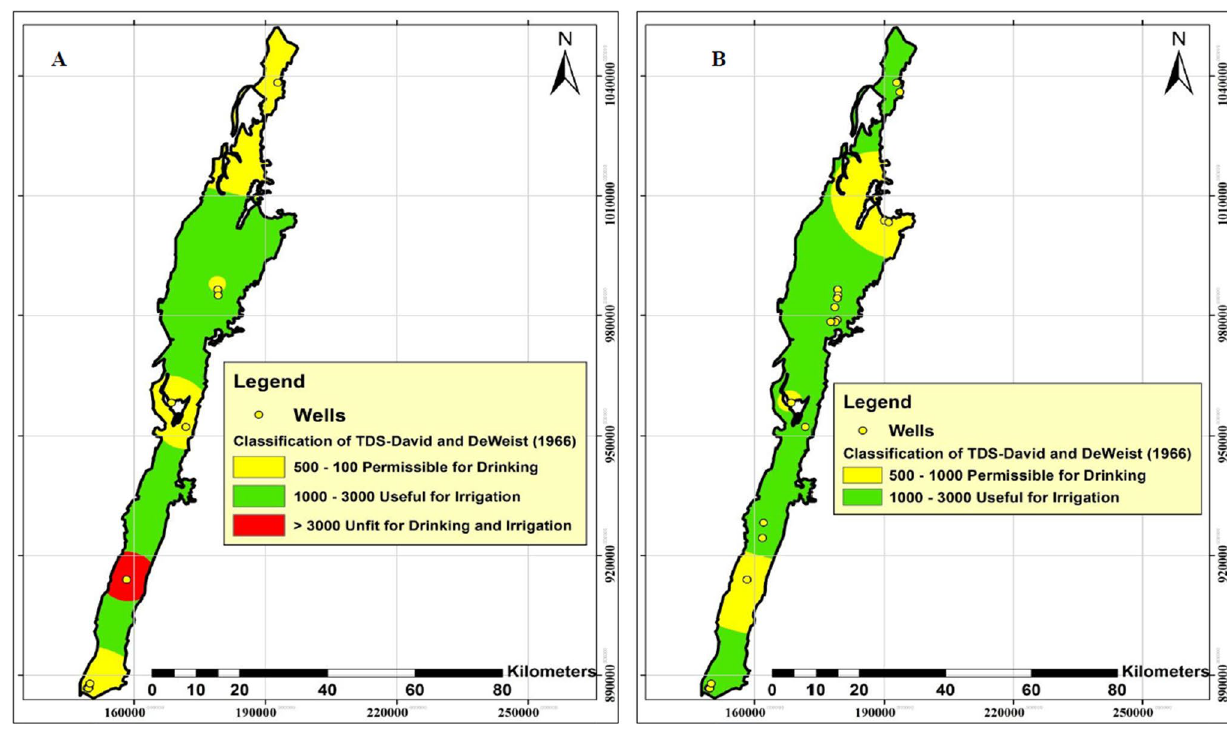
Fig. 5 Spatial variation in TDS (mg/l) of groundwater samples based on Davis and DeWiest classification (1966). A Spring season (April–May 2019). B Autumn season (August–September